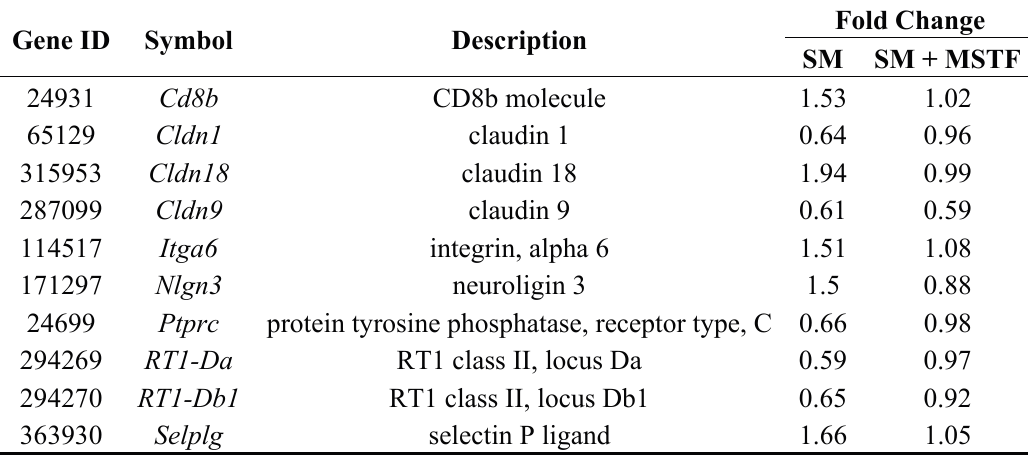
Table 5. List of 10 genes involved in cell adhesion molecules. These SM-induced alterations of expression were abolished or attenuated by MSTF treatment.